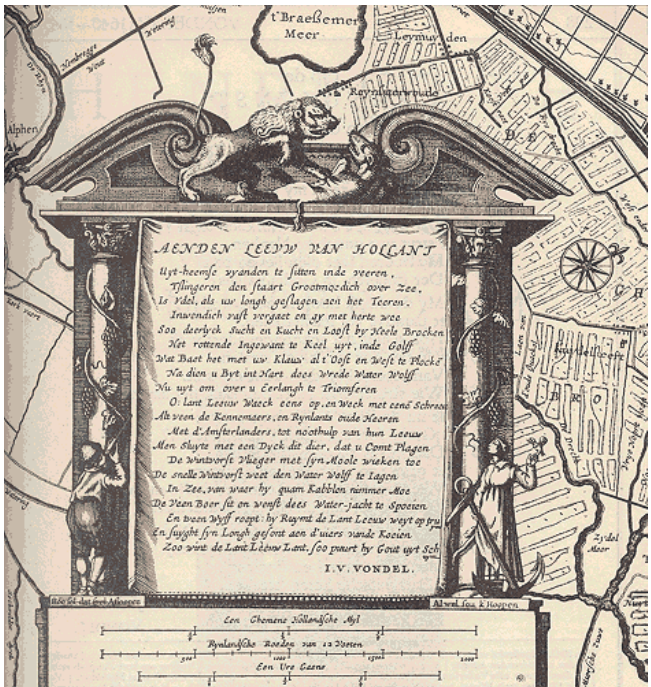
Figure 1. The battle of the Dutch lion against the water-wolf as an allegory of the battle of the Dutch against the water [120].